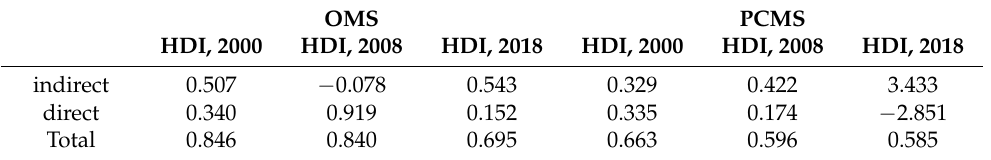
Table 7. The role of direct and indirect paths in explaining the HDI (standardized β coefficients). OMS